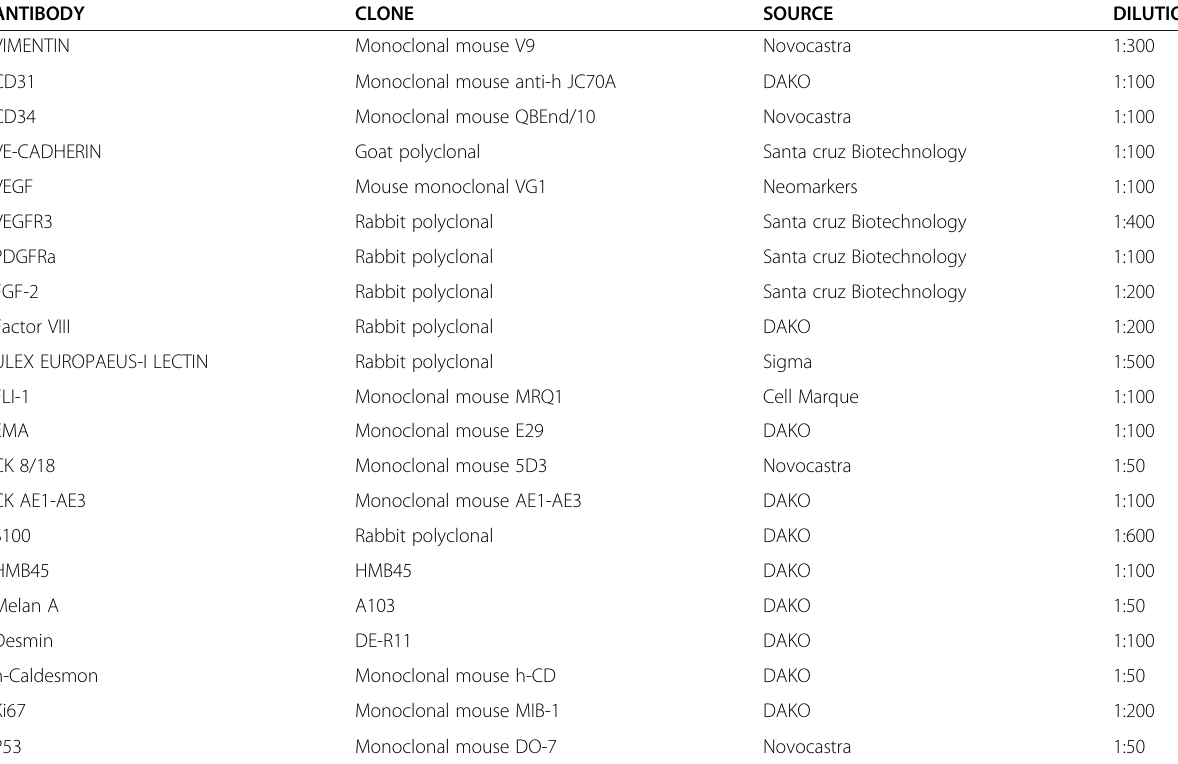
Table 1 List of antibodies